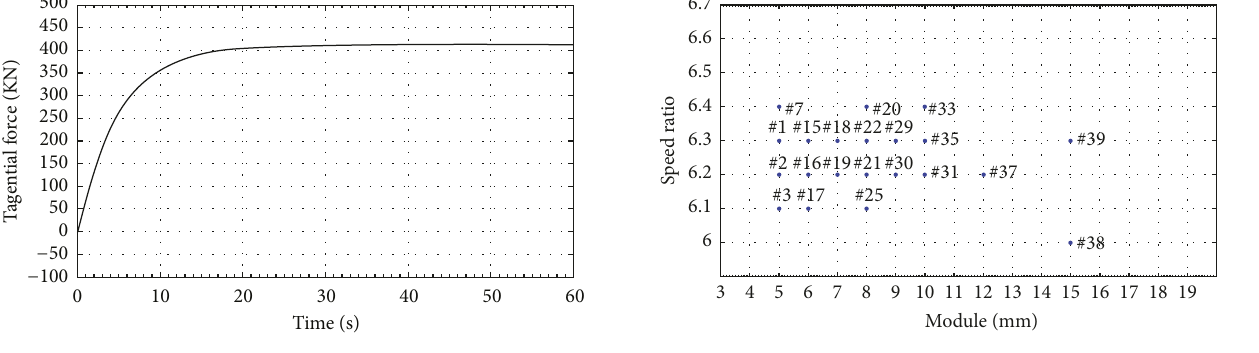
Figure 15: Speed ratio of workable designs of planetary stage.